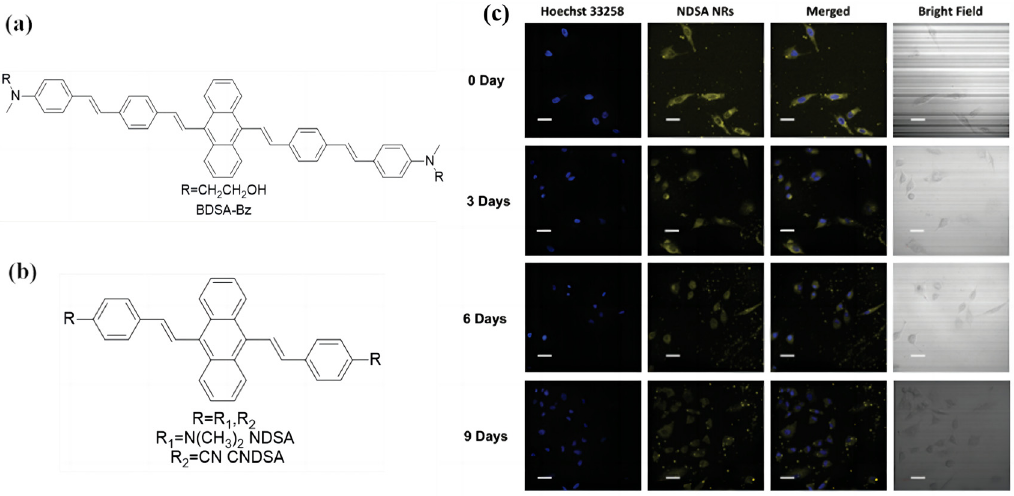
Figure 4. ( a ) Molecular structure of BDSA ‐ Bz. ( b ) Molecular structures of NDSA and CNDSA. ( c ) Long ‐ term cell tracing CLSM images of NDSA NRs incubated at 37 °C for 4 h and then subcultured for fixed time intervals, including day 0, day 3, day 6, and day 9. Scale bar: 20 mm. Adapted with permission from [68].